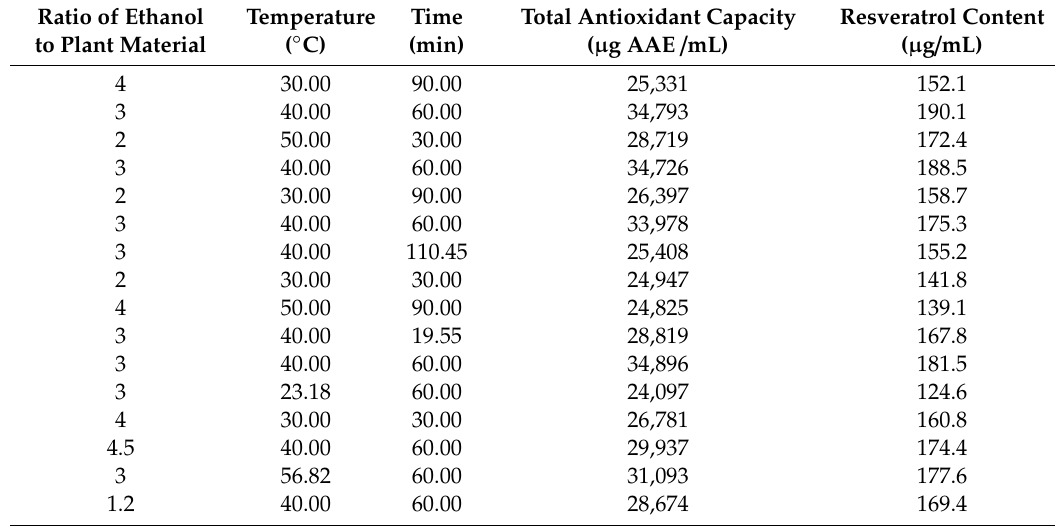
Table 1. Experimental